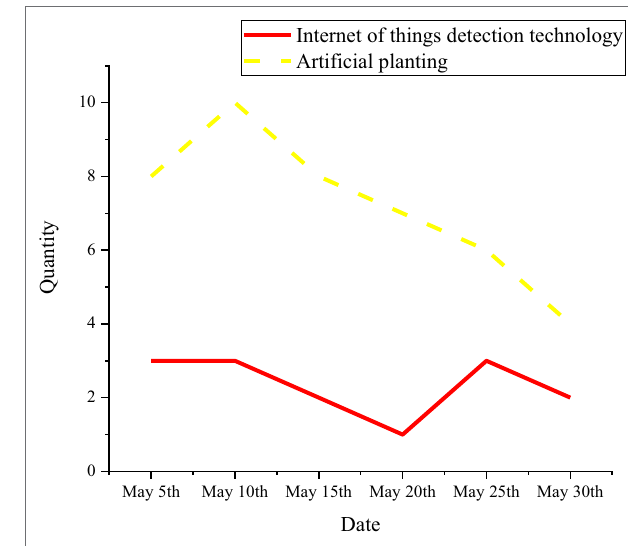
FIGURE 14 | Humidity changes monitored by the IoT in greenhouse corn under different